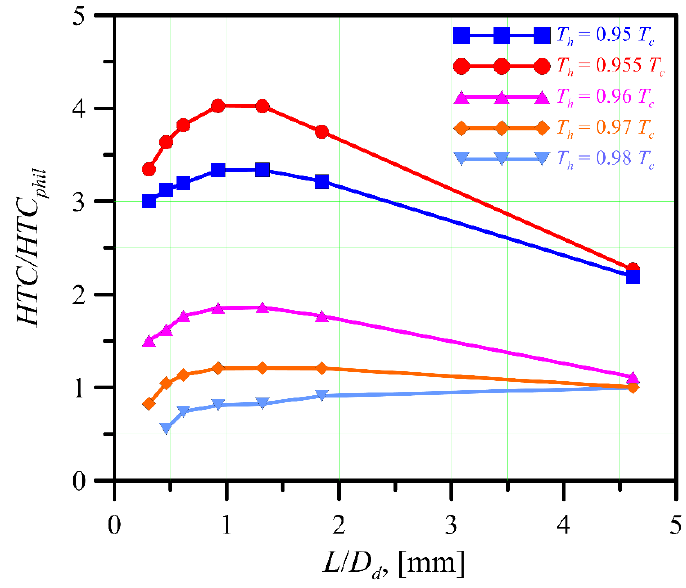
Figure 9. Enhancement factor for heat transfer on the surfaces with contrast wettability depending on the distance between the lyophobic zones L / D d for different heater temperatures T h .